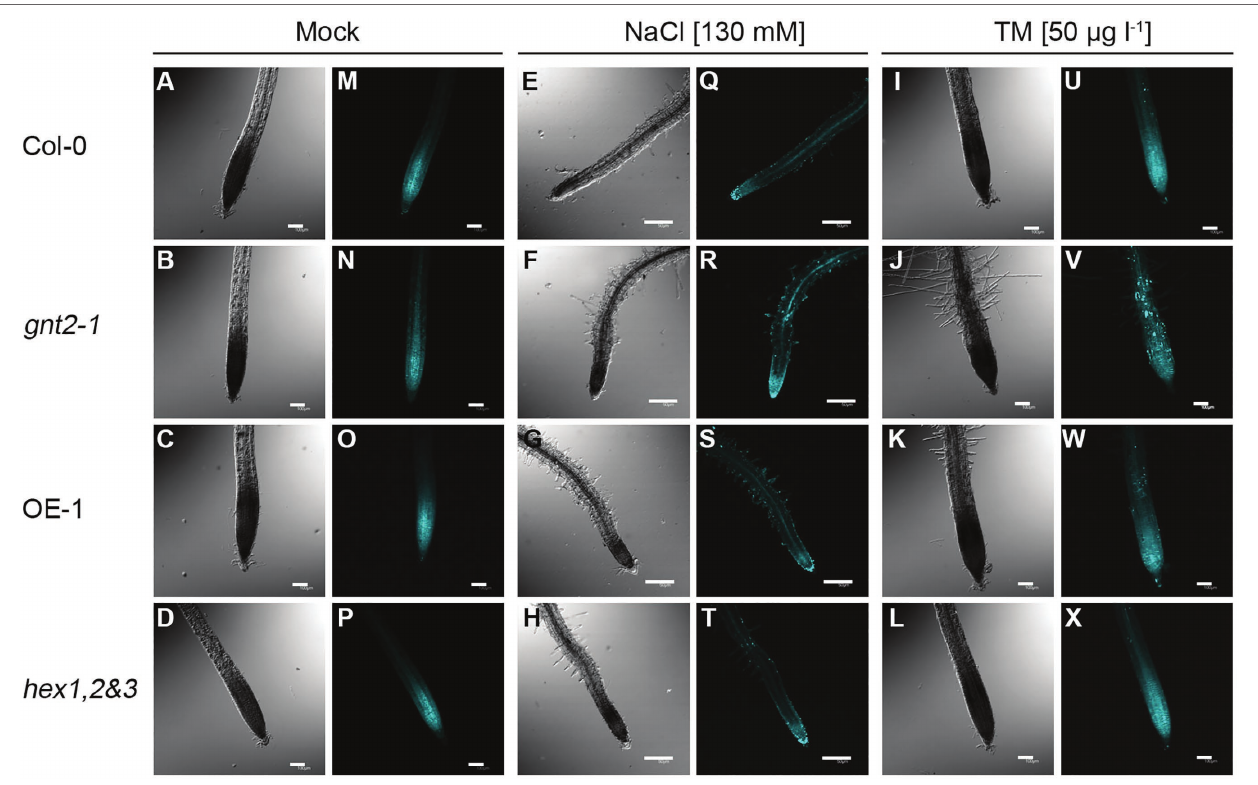
FIGURE 2 | The gnt2-1 mutant enhances the punctate pattern of callose deposition under prolonged stress conditions. In situ callose deposition at the root tip was visualized by aniline blue staining and viewed by fluorescence microscopy. (A–X) Five-day-old Col-0, gnt2-1 , OE-1, and hex1,2&3 plants were further grown on MS medium (A–D, M–P) , MS medium supplemented with 130 mm NaCl (E–H, Q–T) or MS medium supplemented with 50 μ g l − 1 TM (I–L, U–X) for 4 day, respectively, and stained with 0.005% discolorized aniline blue. The punctate pattern of callose deposition was visualized by using a fluorescent microscope equipped with a DAPI filter set. Notice the strong punctate callose deposition in gnt2-1 plants under prolonged stress conditions (R,V) . Scale bar in mock and TM treatment = 100 μ m, scale bar in NaCl treatment = 50 μ